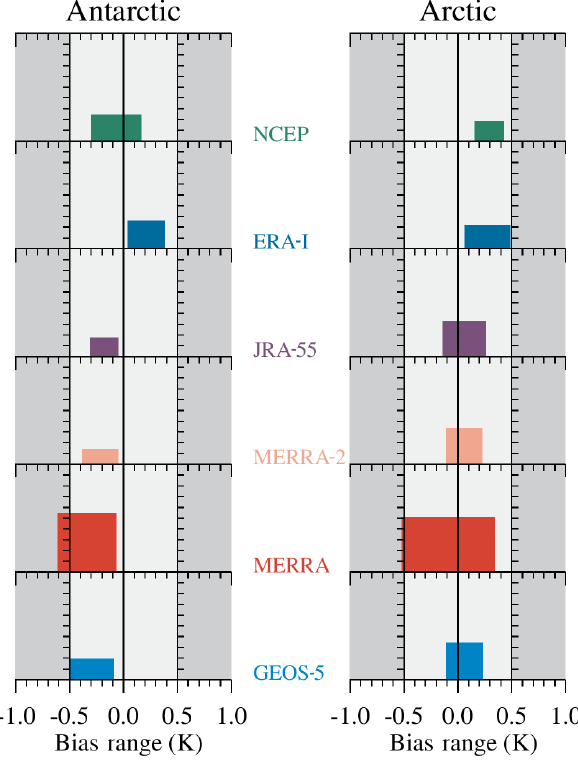
Figure 7. Temperature bias ranges of the reanalyses relative to COSMIC GPS RO for Antarctic and Arctic winters 2008–2013, poleward of 60 ◦ , and for pressure levels 68–21hPa, derived from the data in Fig. 6. The bias ranges are obtained from the extrema of the individual yearly mean bias values over 68–21hPa. Each colored box indicates the bias ranges for the particular reanalysis scheme given in the legend; the abscissa gives the range of min- imum to maximum bias; the ordinate gives the largest meridional bias range. Light gray shading indicates a ± 0.5K scale in the bias range and a 0–1K scale for the meridional bias range.